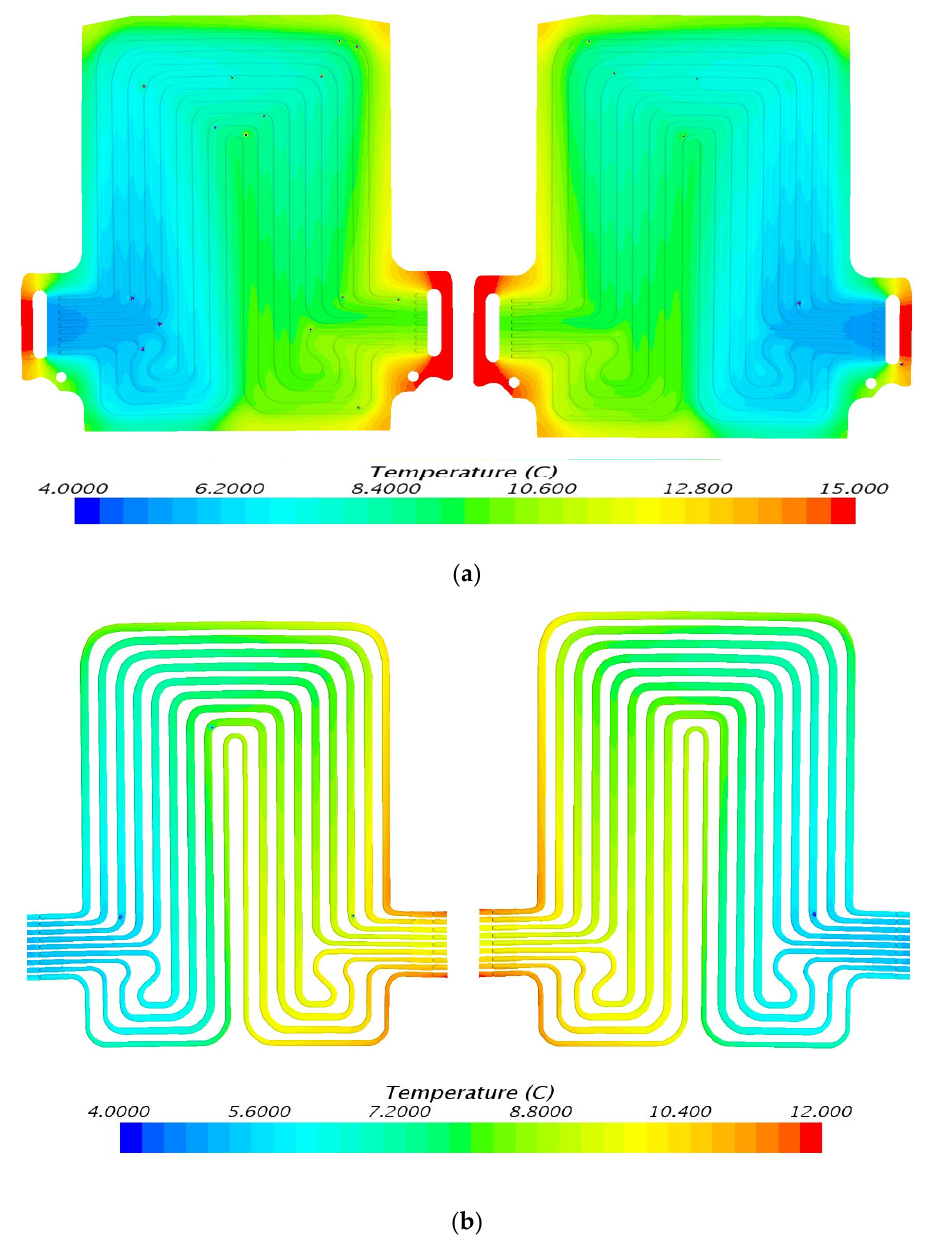
Figure 11. Temperature profile at 80 A and 5 ◦ C with heat flux values near cathode = 3112.2 W / m 2 , anode = 3072.8 W / m 2 , and mid surface = 764.1 W / m 2 . ( a ) Top view and ( b ) bottom view.